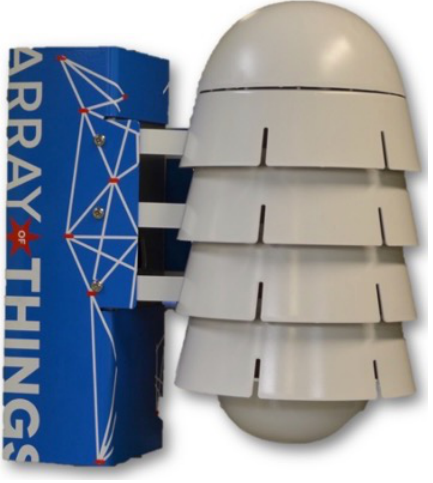
Fig. 2 An AoT node. Computers, camera, and light (Ultraviolet (UV), Infrared (IR), and visible) sensors are in the blue enclosure; a cellular modem, camera, environmental (vibration, sound, magnetic field, temperature, relative humidity, and barometric pressure), and air quality (CO, NO 2 , SO 2 , PM2.5, and O 3 ) sensors are in the white